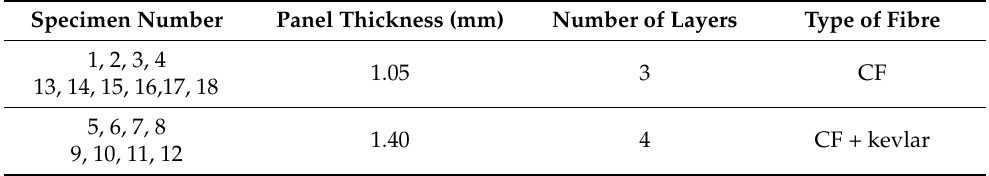
Table 2. Panel lay-up